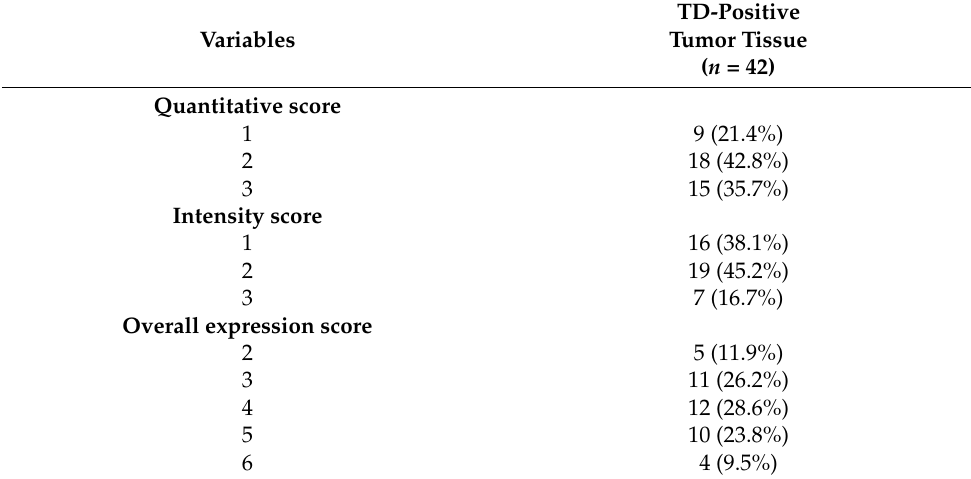
Table 3. IHC staining characteristics in tumor tissue TD-positive RCCs.